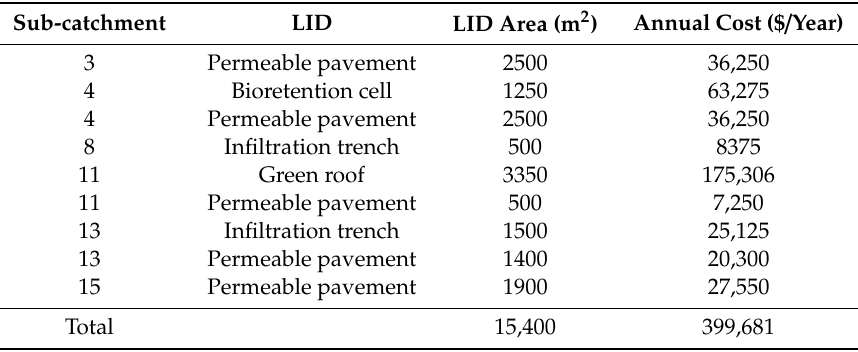
Table 6. Optimized LID